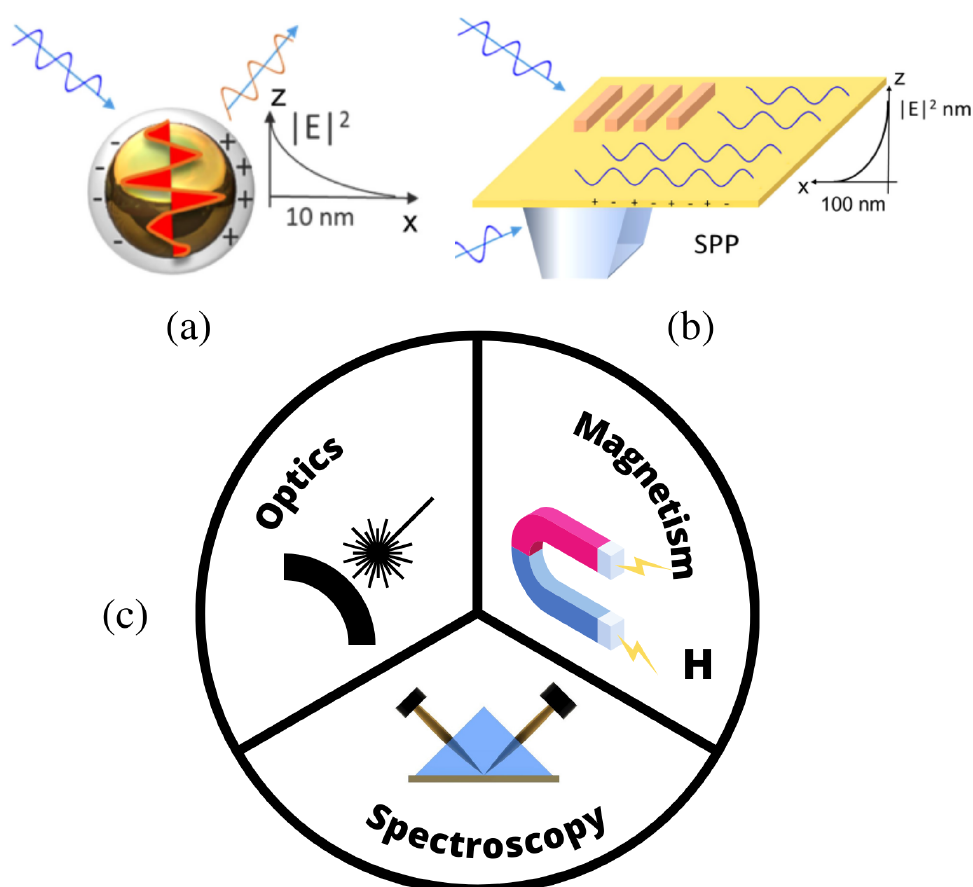
Figure 1. ( a ) Localized surface plasmon resonances (SPRs) and ( b ) propagating SPRs. ( c ) Magneto- plasmonics: merging of optics, magnetism and spectroscopy. Figures ( a , b ) were adapted from the American Institute of Physics, 2021 [70]. Copyright 2021 American Institute of